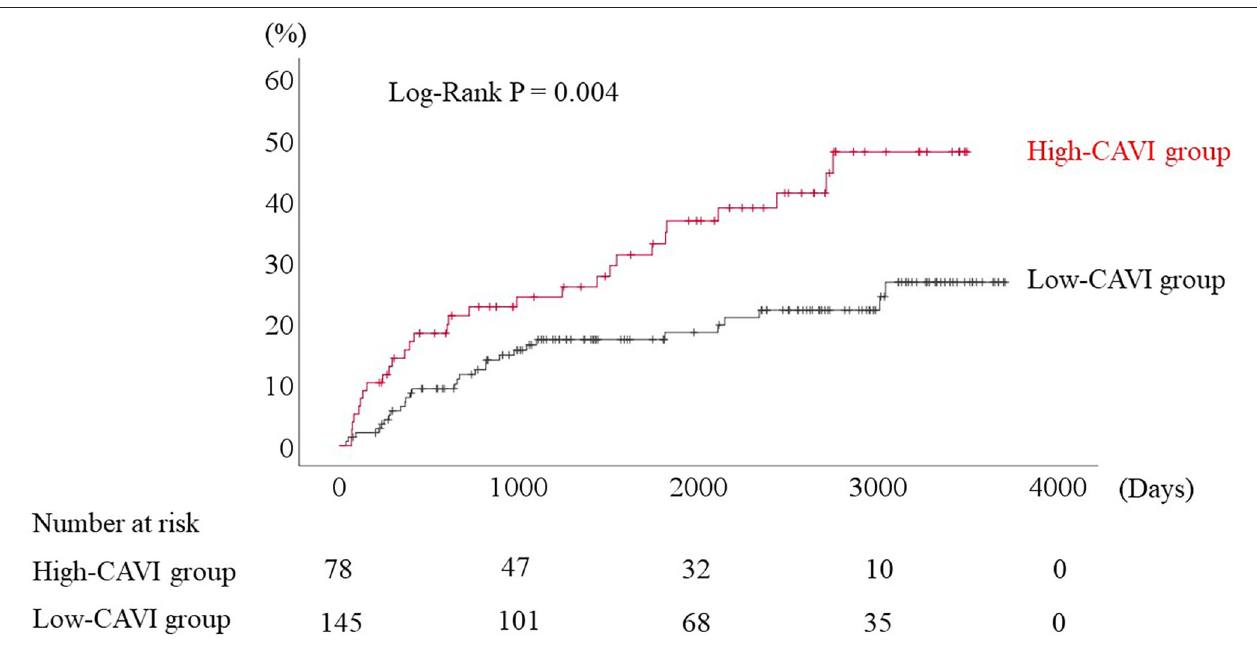
FIGURE 3 | Accumulated cardiac event rates stratified by CAVI.